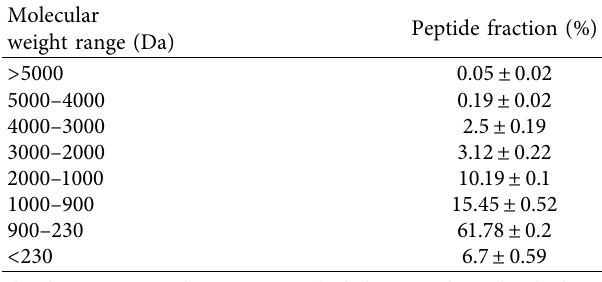
Table 1: Distribution of molecular weight of obtained casein peptides enzymatic hydrolysis at 60 ° C for